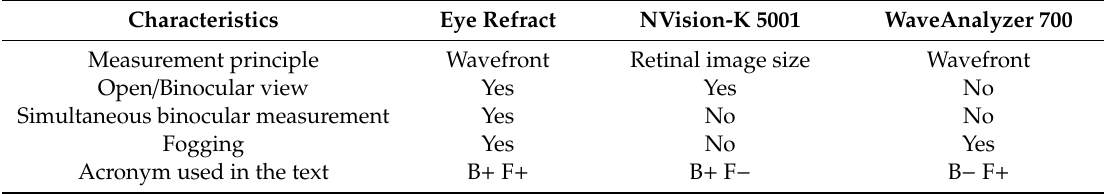
Table 1. Summary of the main di ff erences among the